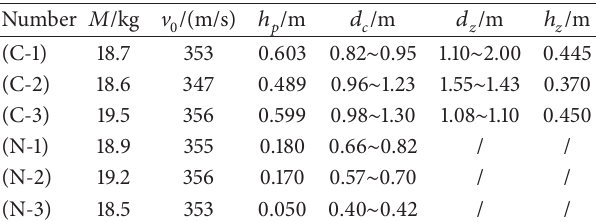
Table 2: Experimental